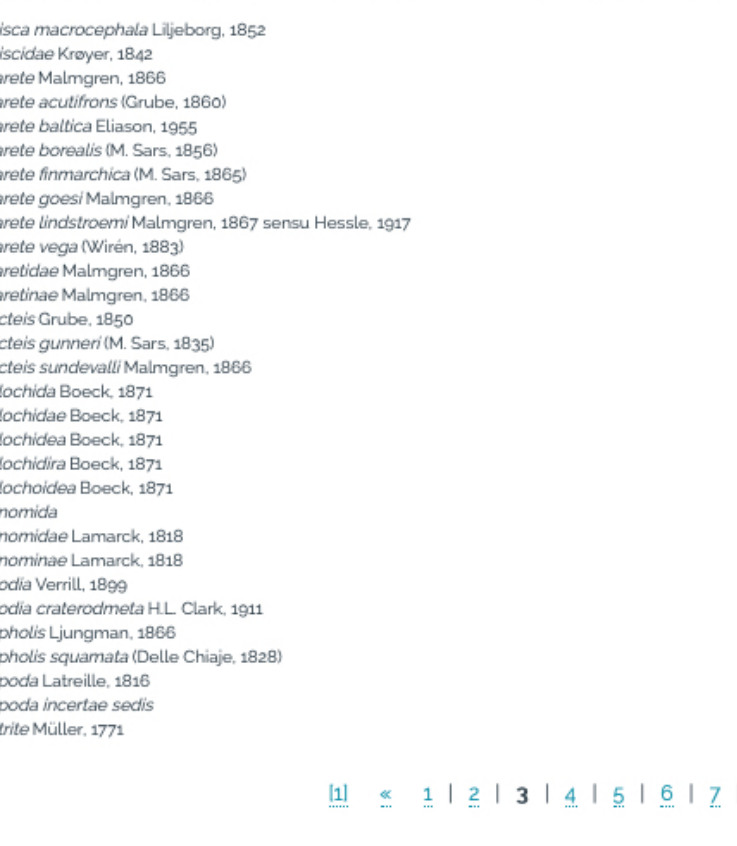
Figure 4. Screenshot of data